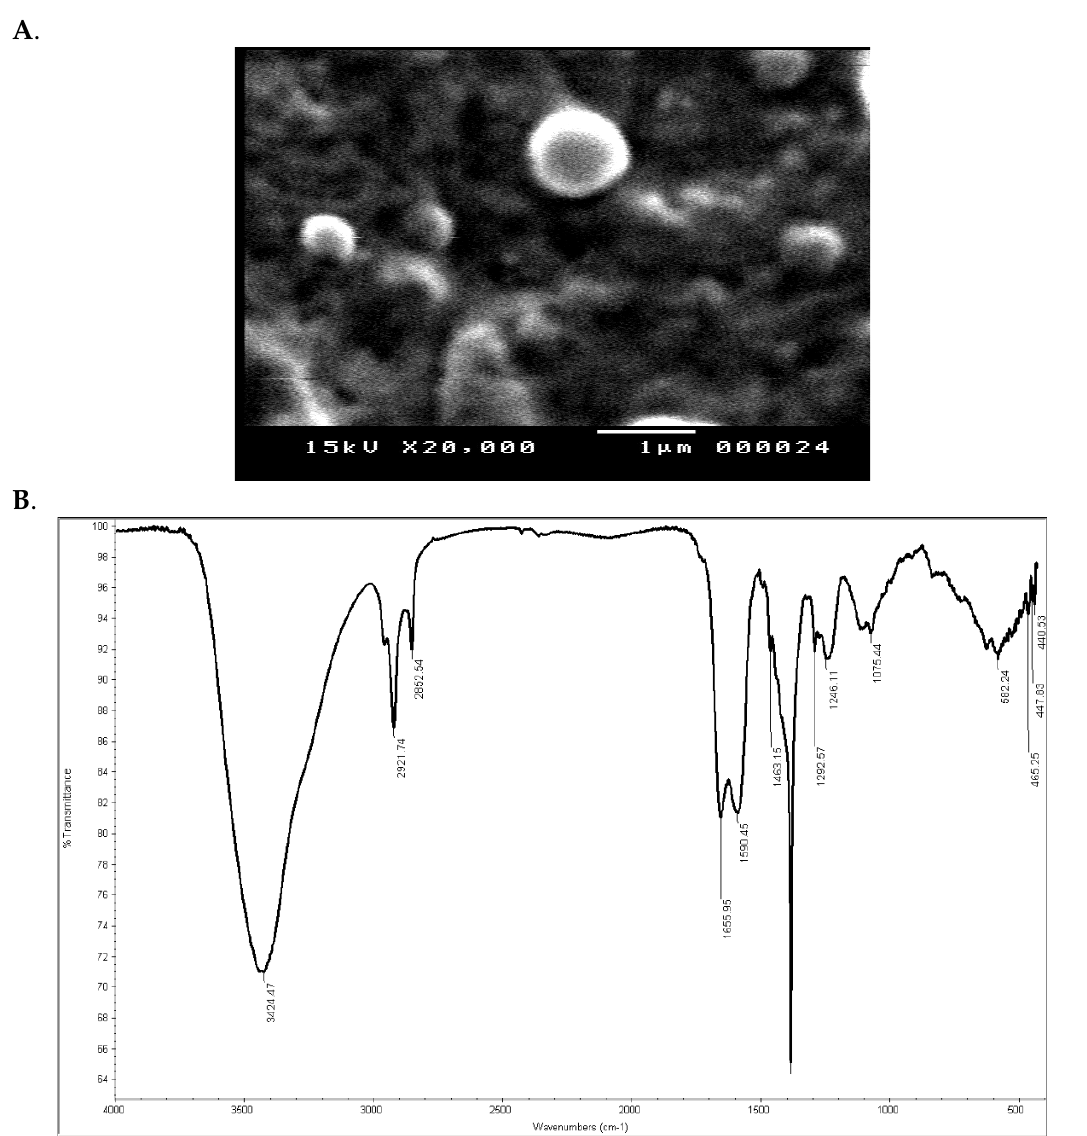
Figure 3. ( A , B ). SEM micrograph and FTIR spectrum for the synthesized PVP-AgNPs, respectively.